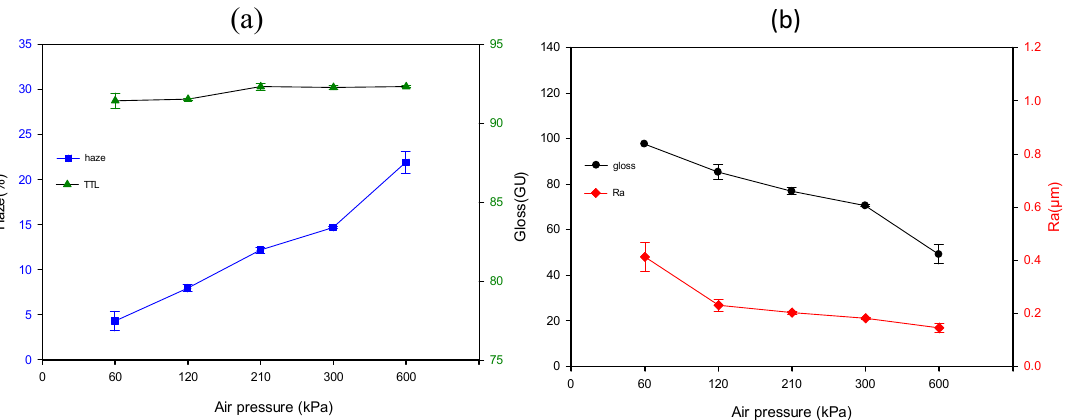
Figure 5. The influence of air transport pressure on ( a ) haze and TTL and ( b ) gloss and Ra with the sol-gel deliver pressure and displacement speed of 120 kPa and 300 mm/s, respectively.